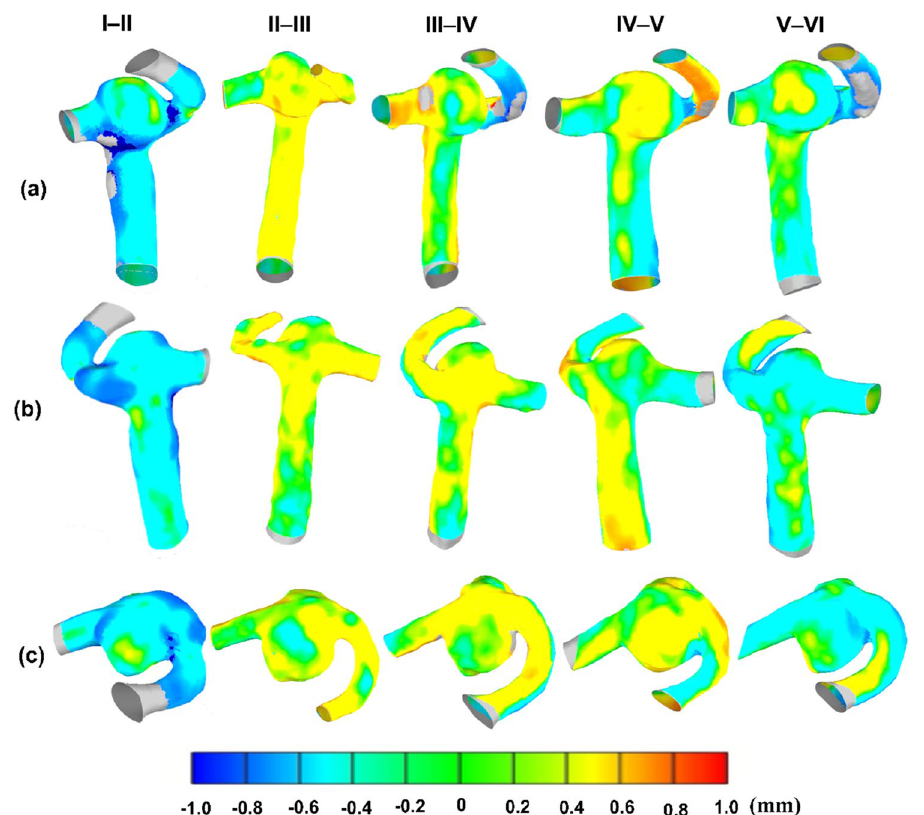
Figure 7. Colour contours representing the differences in the shape and size of the aneurysm over a decade. ( a ) Front view; ( b ) Back view; ( c ) Top view; I–II: Timepoint II compared to timepoint I with timepoint I as